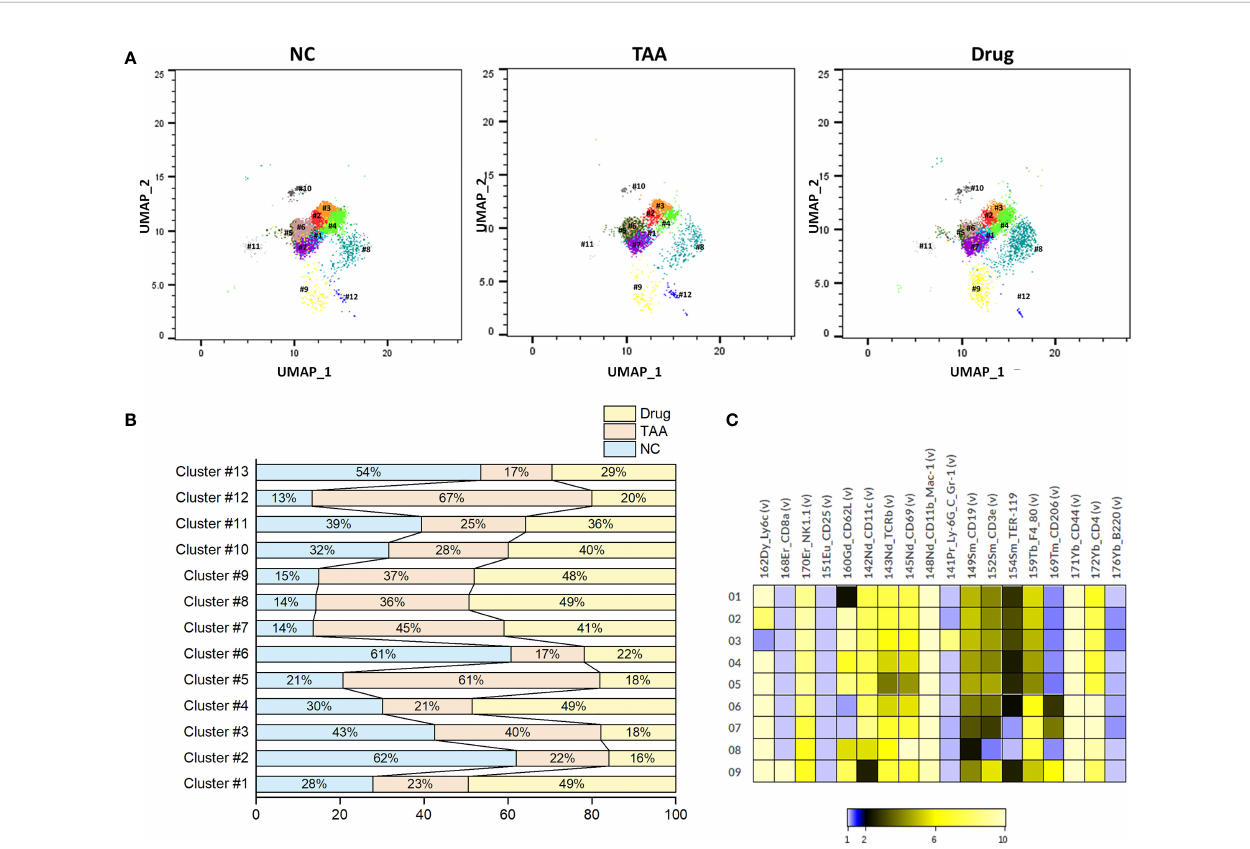
FIGURE 6 | Phenograph sub-clusters of NK cells. (A) PhenoGraph cluster analysis of manual gated NK cells of NC, TAA, and Drug groups. (B) Population differences of NK cell sub-clusters represented in bar graph (%). (C) Intensity of surface marker expression of NK cells represented in heat map